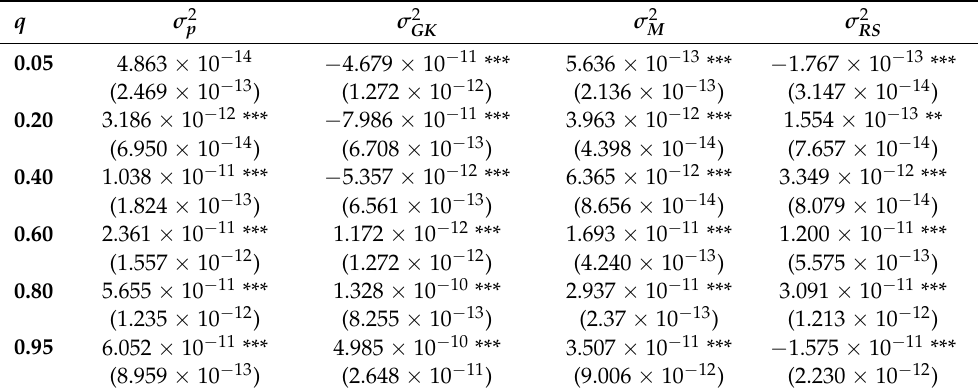
Table 3. Trading volume impact on Eurobank’s stock return